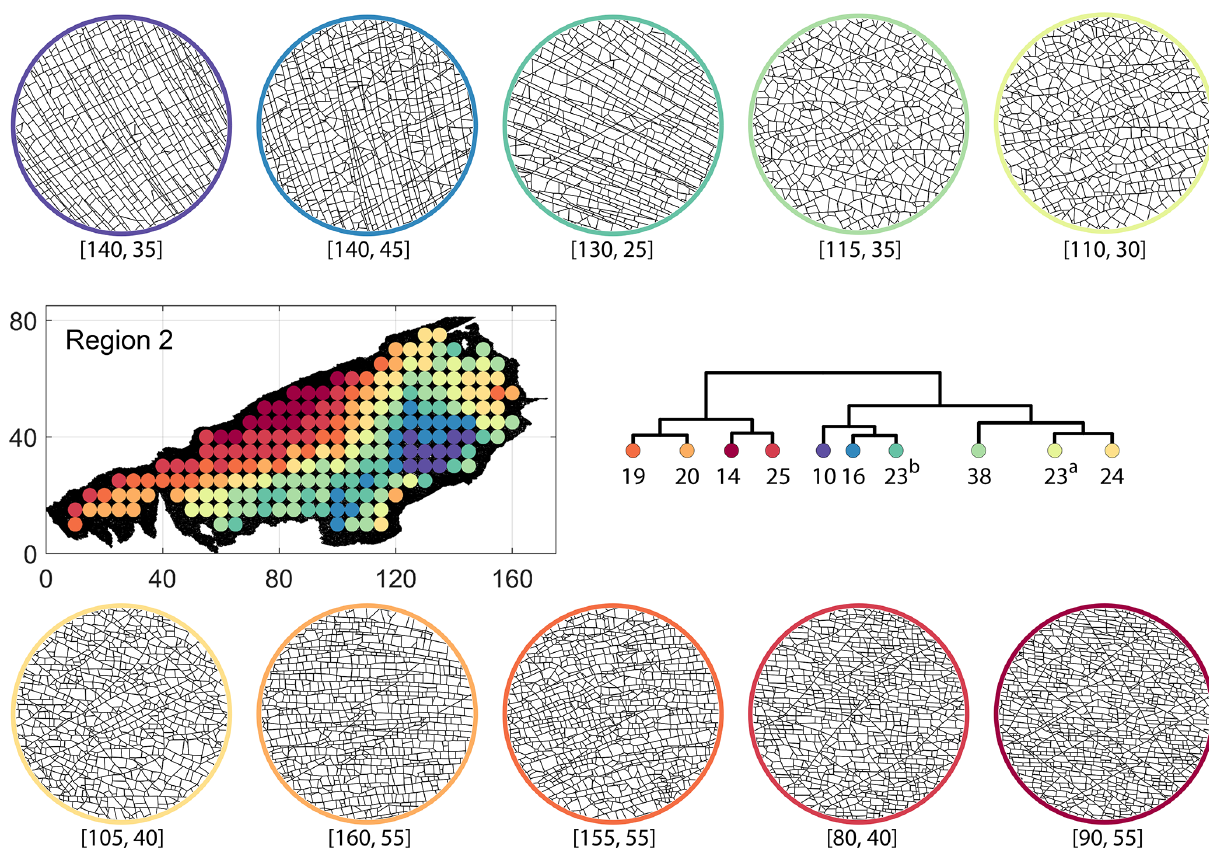
Figure C5. Circular subgraph samples depicting variation in fracturing style as identified in the 10 largest clusters by D-measure in Region 2. Coordinates of circular sample centres are below each subgraph